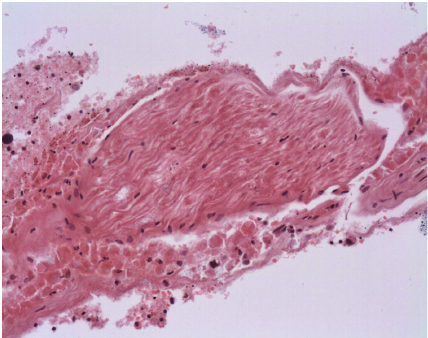
Figure 2: Hypoglossal nerve showing extensive perineural carcino- matous